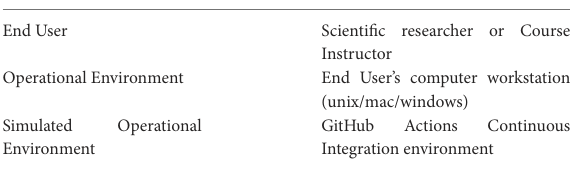
TABLE 4 AUL definitions for